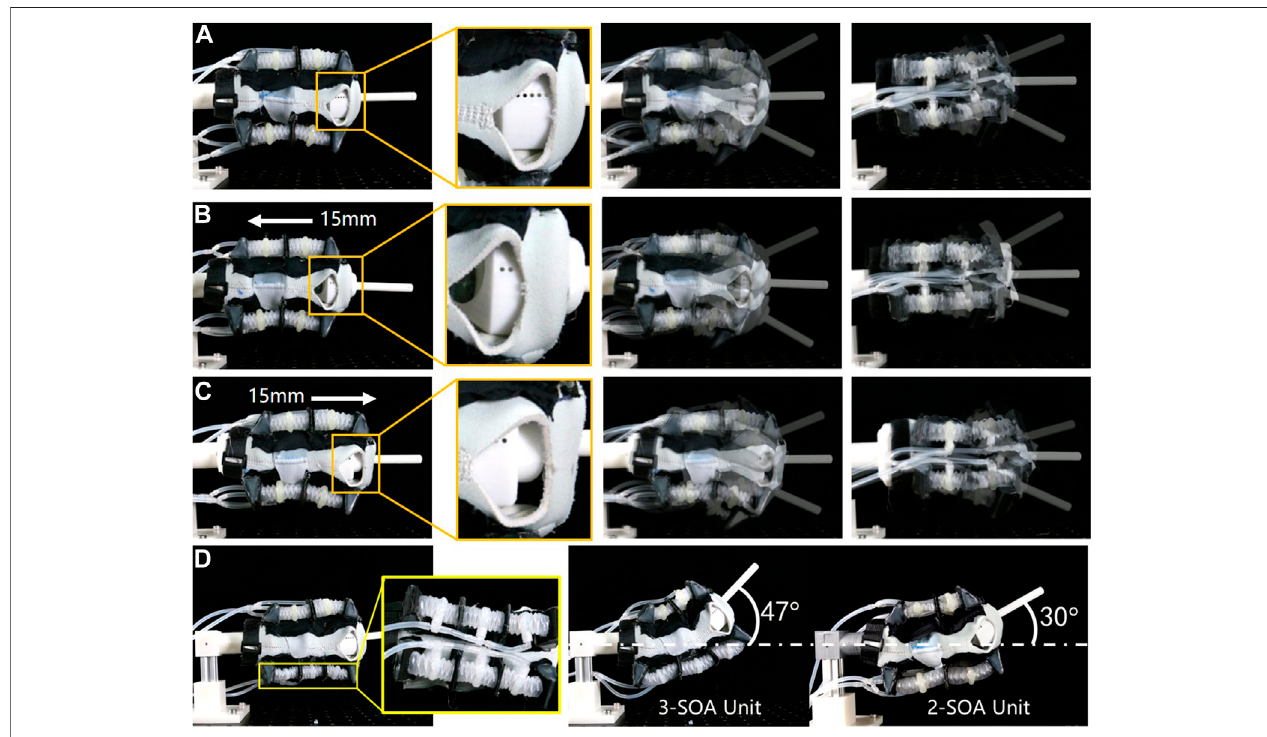
FIGURE10| Thetestsontheadaptivity inwearingpositionand themodularityoftheSOAwerecarried out; (A) theSRbracewaswornonthetestrigattheneutral position; (B) the SR brace was pulled 15 mm toward the forearm; (C) theSR brace was moved 15 mm toward the fi ngers; (D) byreplacing the 2-SOA units with 3-SOA units at the palmar side, a new variation of the SR brace was produced with increased extension